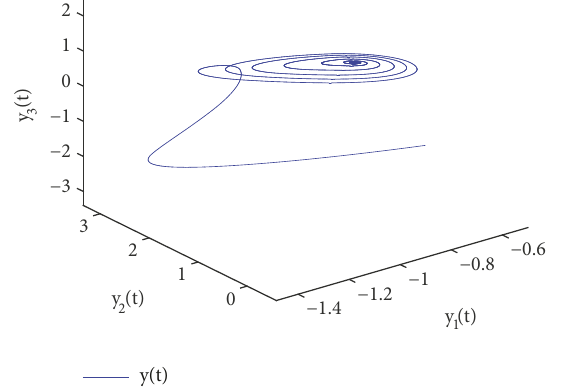
Figure 2: Phase plot of slave system with initial condition 𝑦(0) = (−0.5,1.5, −2.5) 𝑇 without the controller u(t).